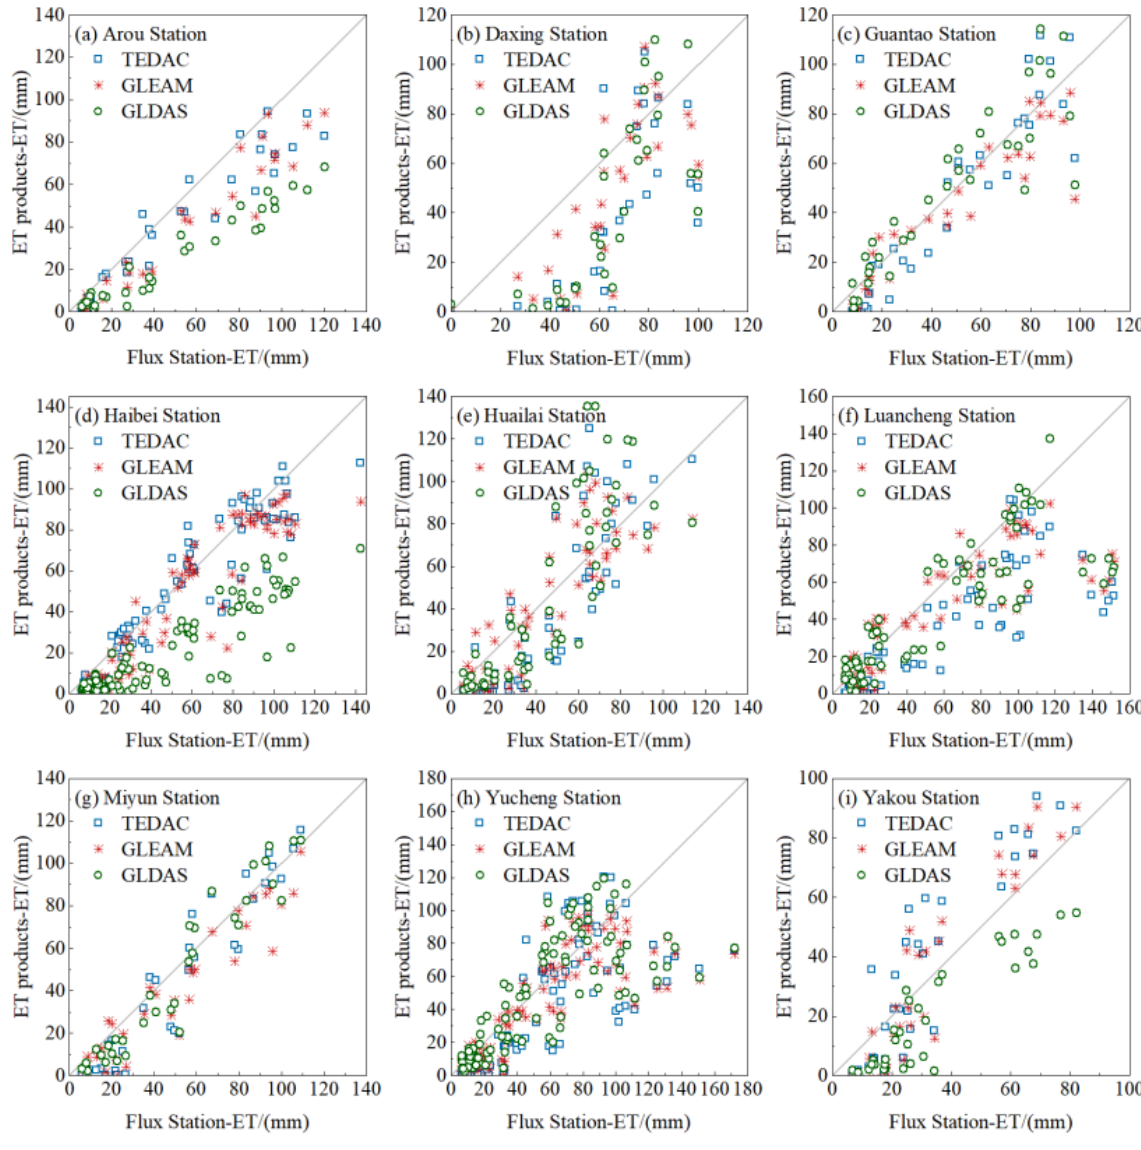
Figure 2. Correlation between the values of three evapotranspiration products and evapotranspiration observed at flux stations.